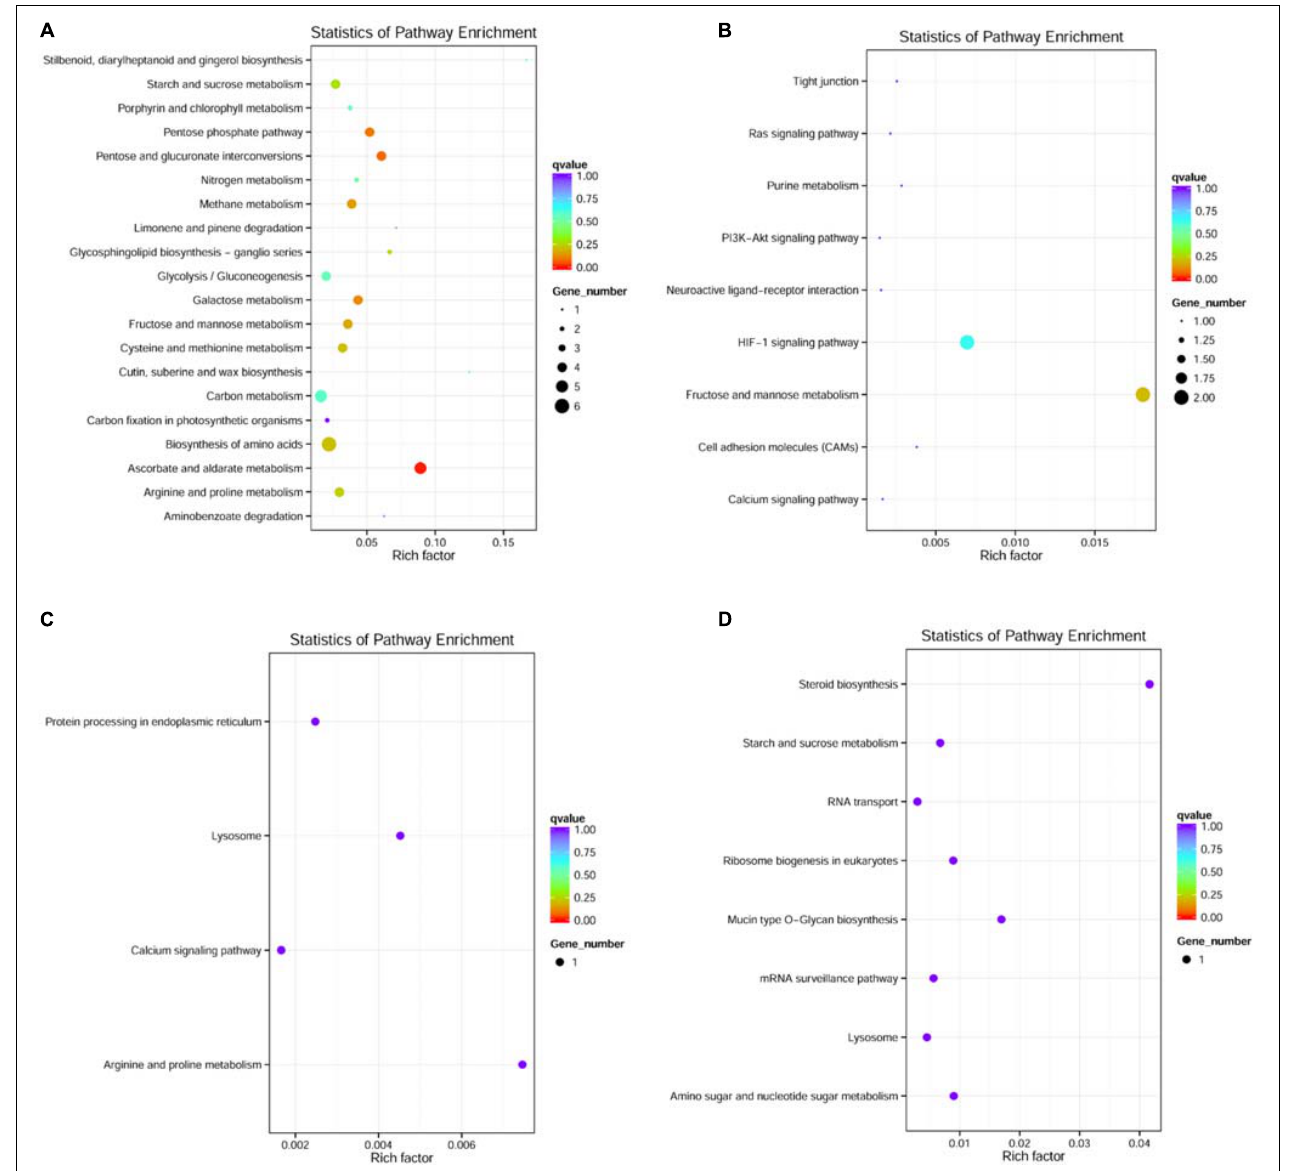
FIGURE 5 | An overview of the KEGG pathways significantly enriched in differentially expressed genes in the (A) muscle, (B) blood, (C) brain, and (D) liver. The specific pathways are plotted along the y-axis, and the x-axis indicates the enrichment factor. The size of the colored dots indicates the number of significantly differentially expressed genes associated with each corresponding pathway: pathways with larger-sized dots contain a higher numbers of genes. The color of the each dot indicates the corrected P -value for the corresponding